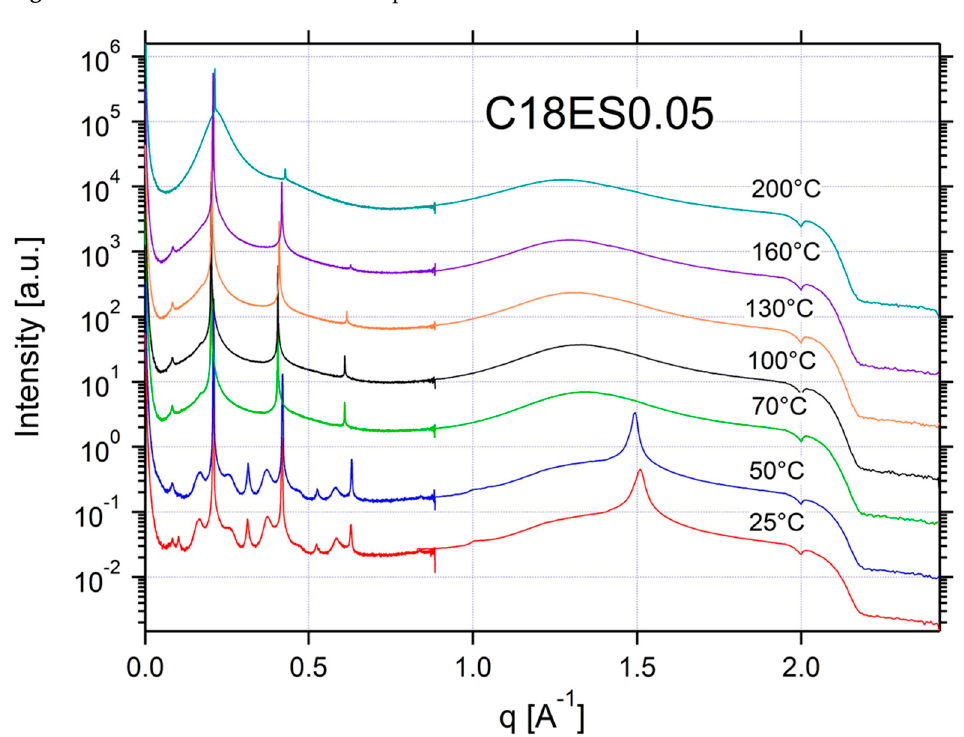
Figure A16. SAXS and WAXS data for 0.05:1 C18ES:C18LiTFSI.